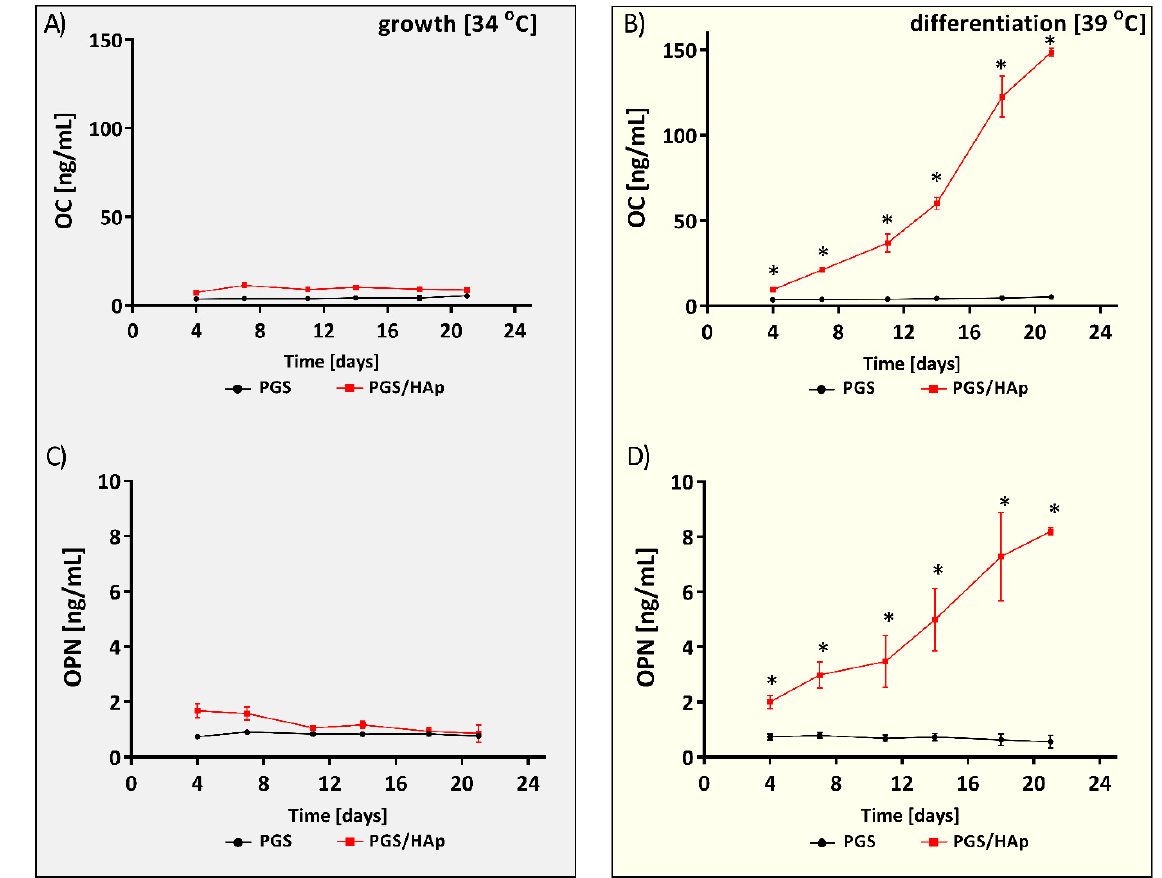
Figure 10. Analysis of the osteogenic markers osteocalcin (OC) and osteopontin (OPN) at conditions facilitating cell proliferation (34 °C) ( A , C ) or under osteoinductive conditions (39 °C) ( B , D ). The results represent the mean concentration ± SD. * p < 0.05 between the PGS and PGS/HAp composites, based on the Mann–Whitney U analysis.